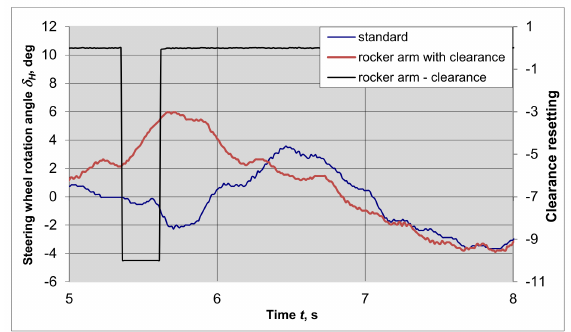
Figure 13. The angles of rotation of the steering wheel during the braking maneuver (initial speed ~70 km/h).